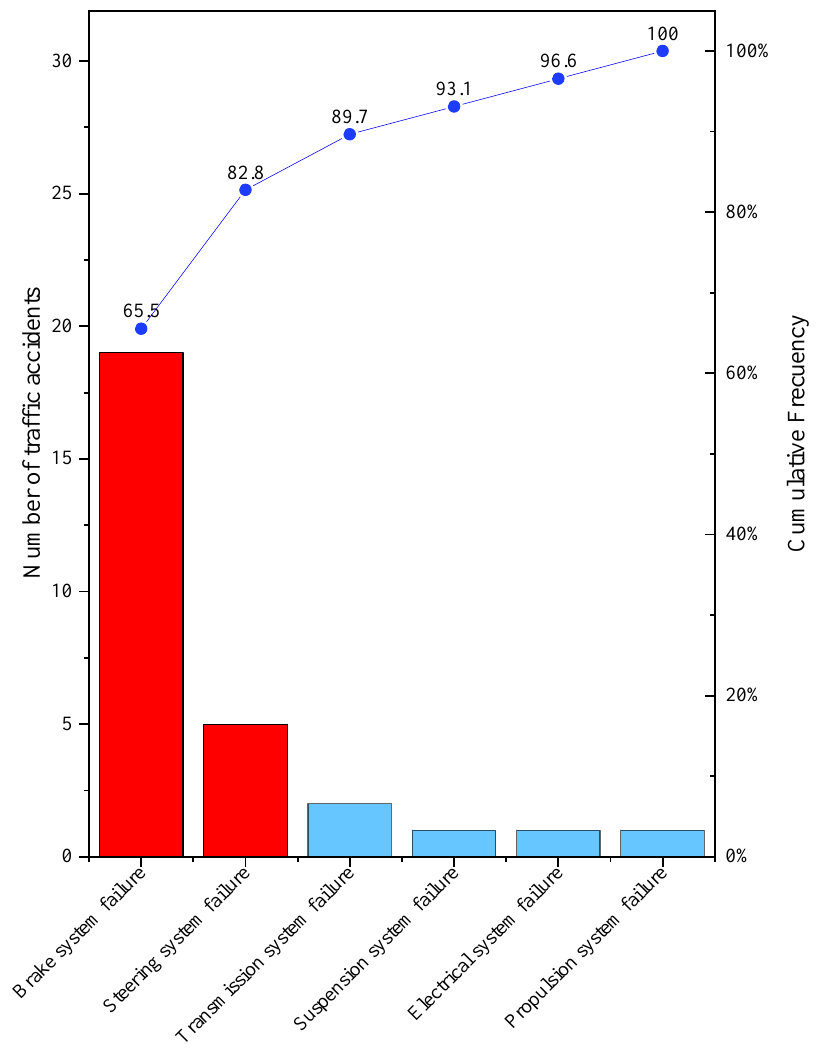
Figure 19. Traffic accident causes recorded for subcategory M1.